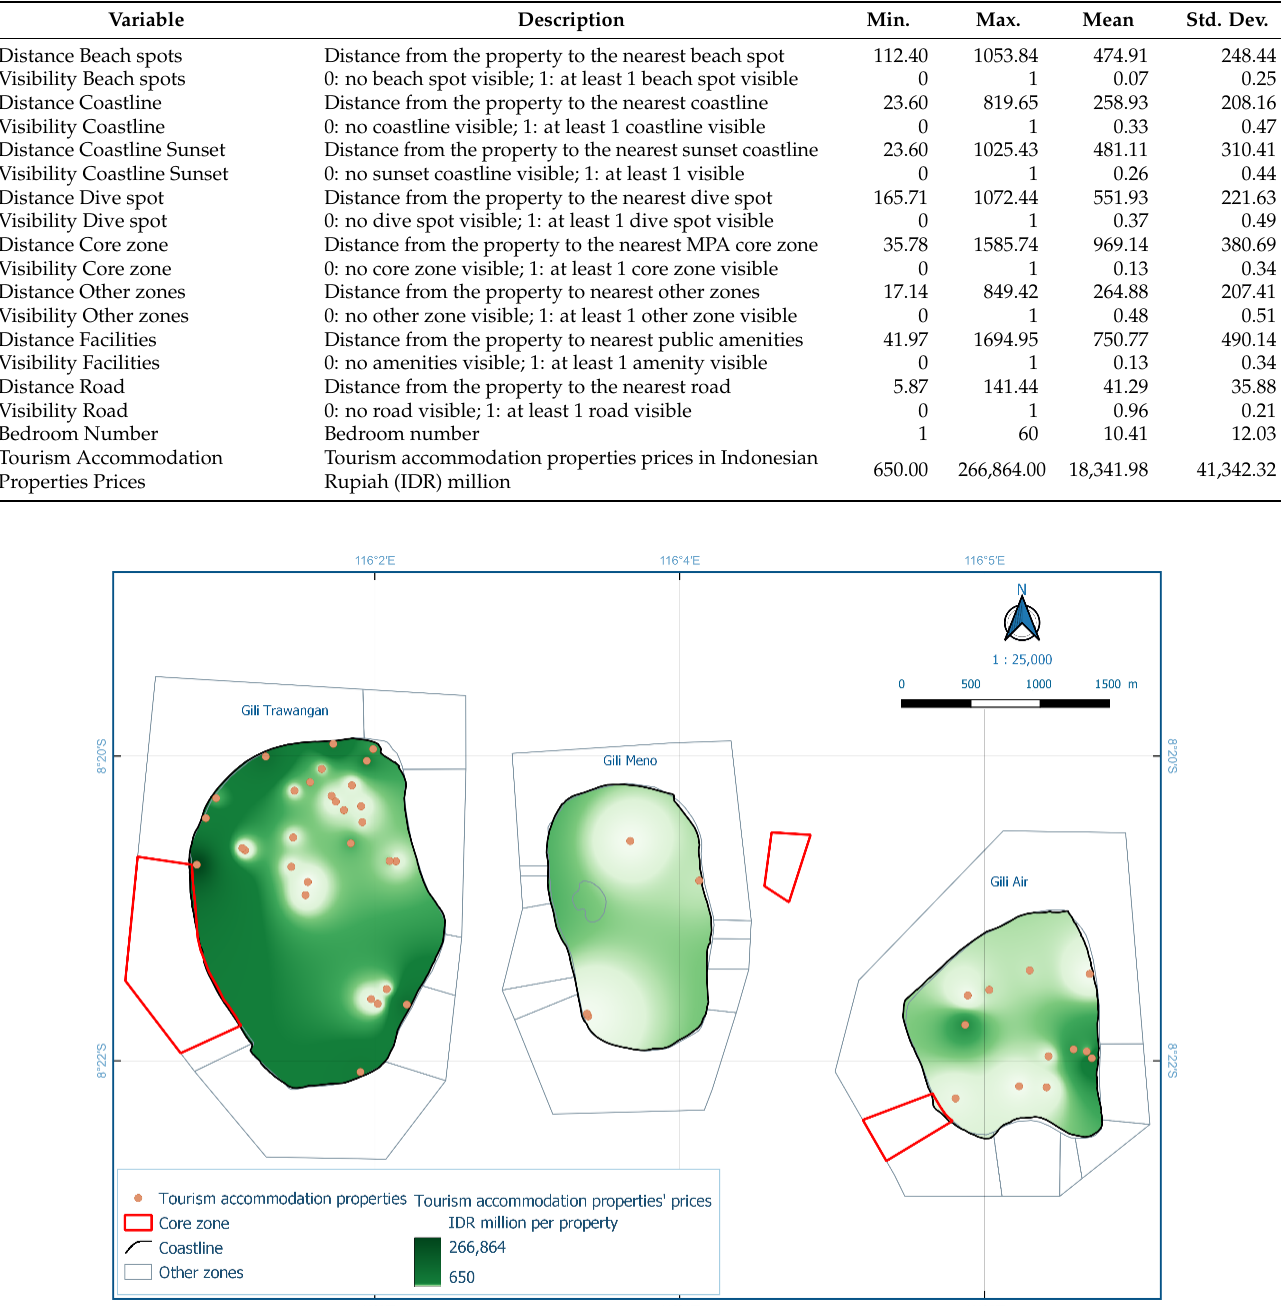
Table 3. Statistical summary for model HT1 of tourism accommodation property prices.